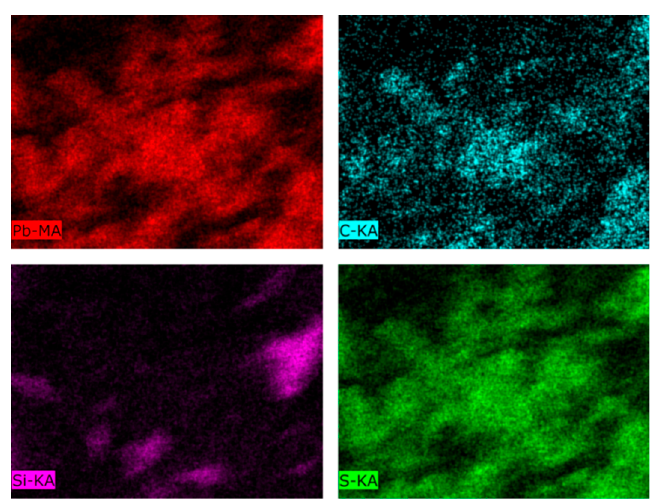
Figure 13. Elemental mapping of Pb, C, Si, and S, individually.